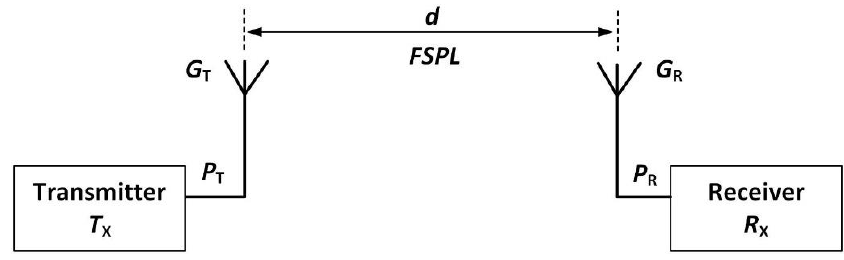
Figure 1 . Representation of the transmitter and receiver setup for FSPL calculations. Figure 1. Representation of the transmitter and receiver setup for FSPL